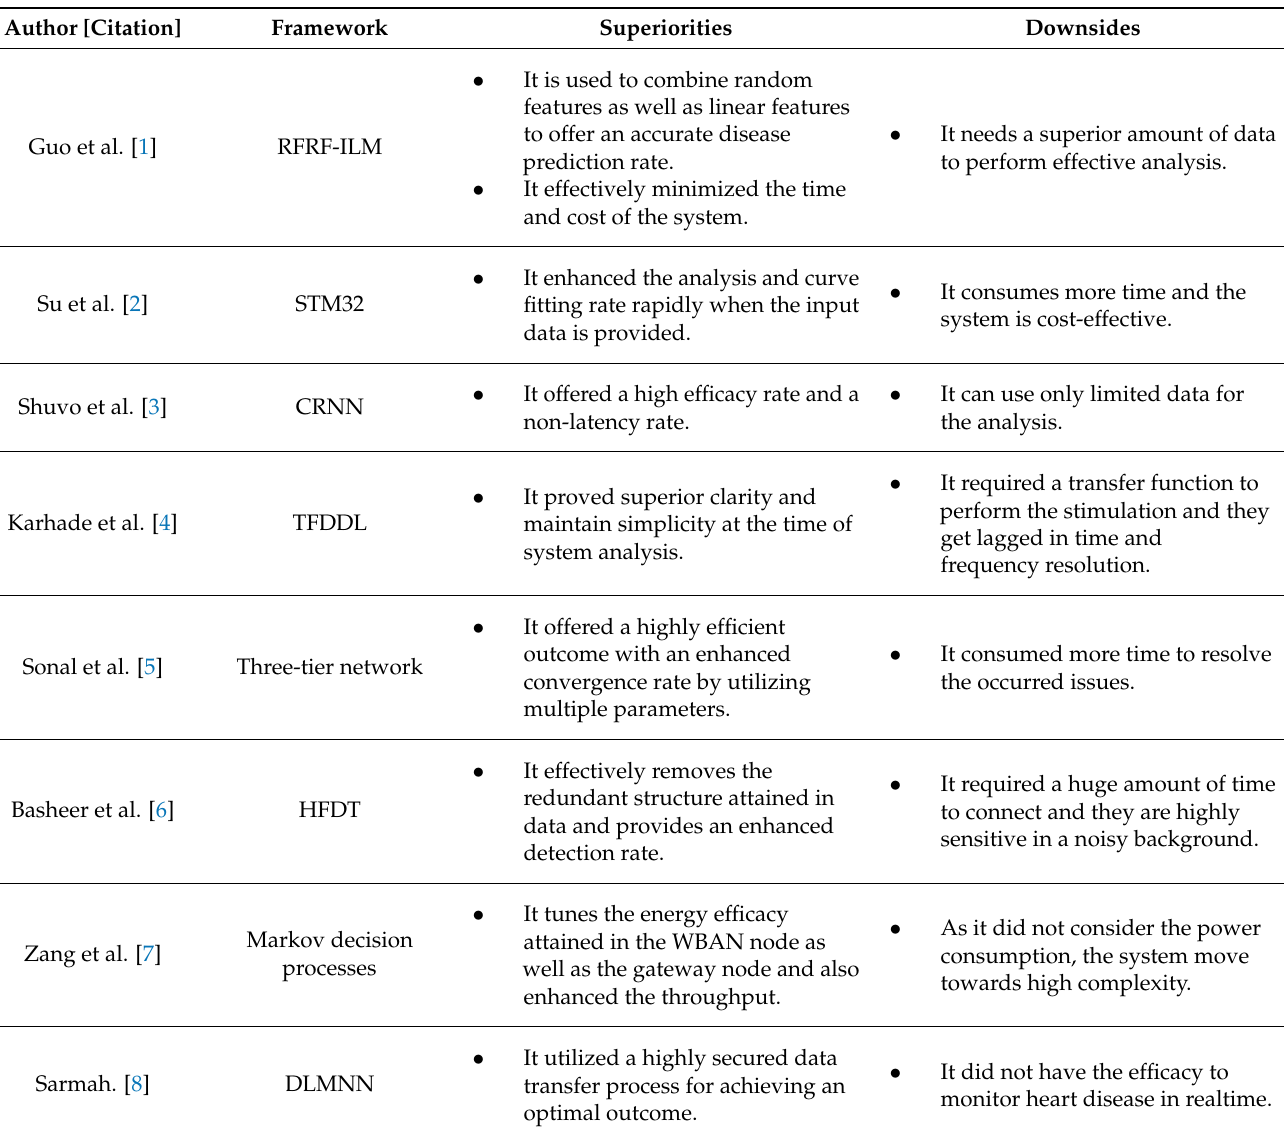
Table 1. Superiorities and downsides of existing heart disease prediction model in WBAN with deep learning